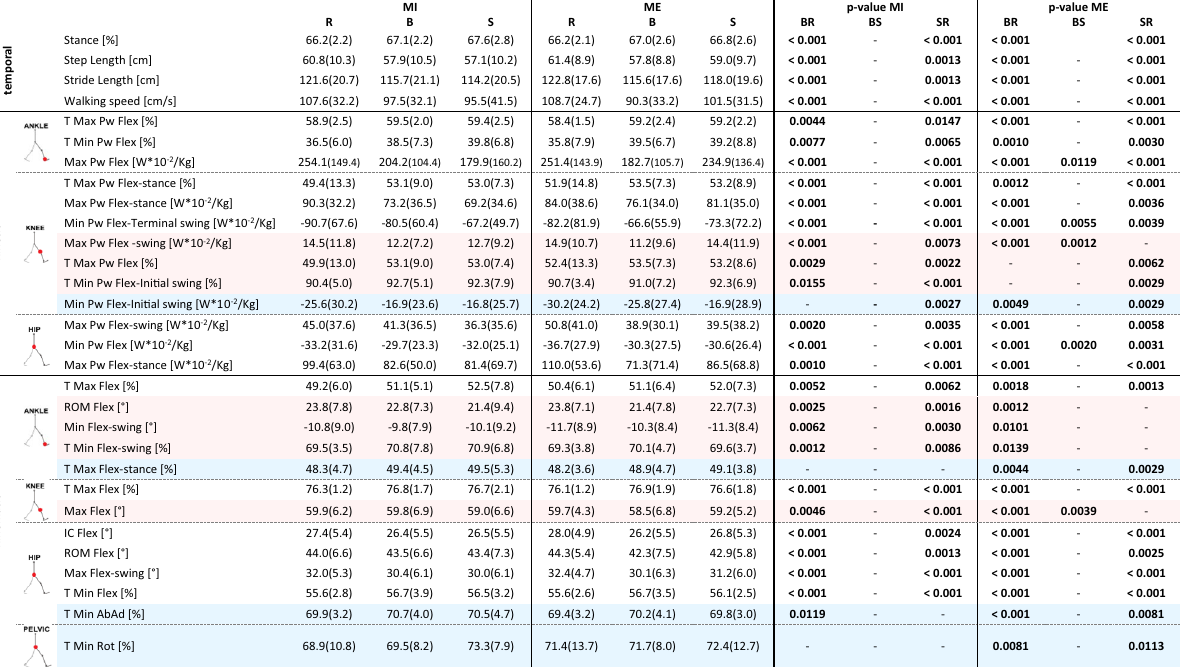
Table 1. Results of the inter-scenarios analysis showing statistically significant results at the Friedman Test (p < 0.05), and having significant results at the post hoc test between the risky scenario versus the baseline (BR) as well as the risky scenario versus the safe one (SR) (Wilcoxon Test with Bonferroni correction, with p < 0.016) at least in one condition (MI and/or ME) are presented (“risky-scenario-driven” approach). Median and IQR values are reported. To improve readability, parameters having significant differences in both conditions (MI and ME) are reported on white background. Parameters having significant differences only in the MI condition are reported on pink background. Parameters having significant differences only in the ME condition are reported on light blue background. MI: Motor Interference condition, ME: Motor Expectation condition, B: Baseline, R: Risky scenario, S: Safe scenario, BR: Baseline vs. Risky scenario, SR: Safe scenario vs. Risky scenario, BS: Baseline vs. Safe